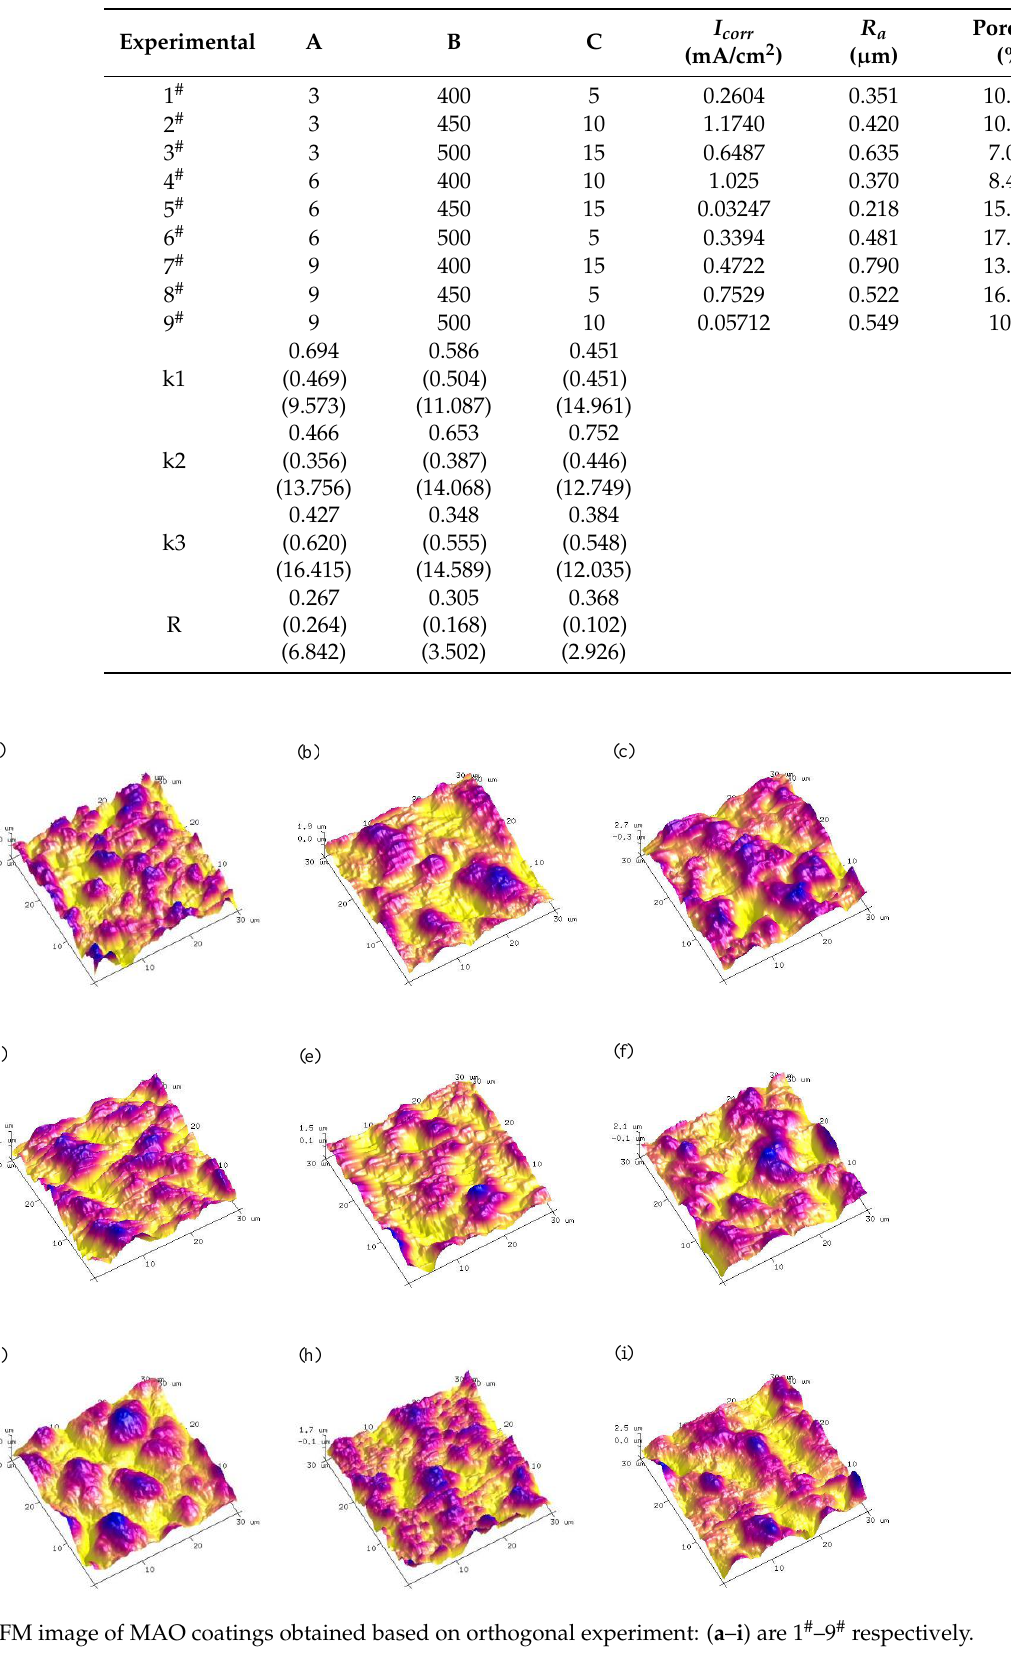
Table 2. Orthogonal experimental array and experimental results.